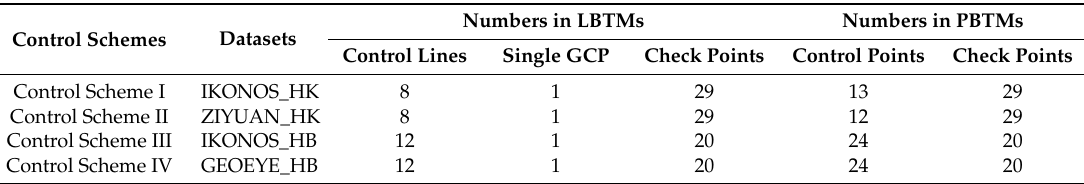
Table 2. Numbers of control conditions of Control Schemes I to IV on four HRSI datasets. PBTM, Point-Based Transformation Model.